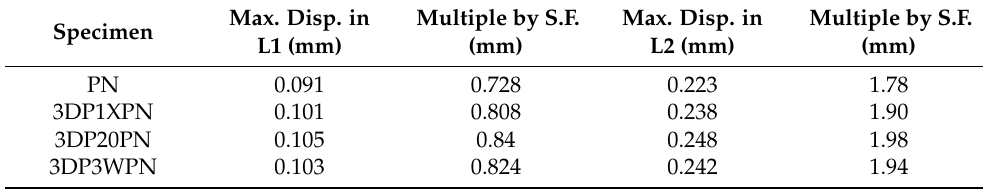
Table 9. Deformations by FEM analysis